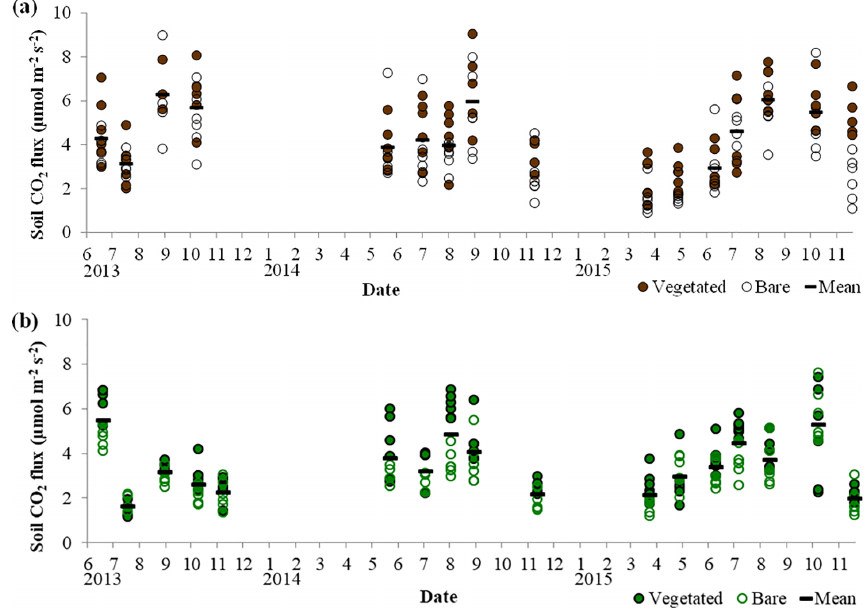
Figure 4. Variations in soil CO 2 efflux for each measurement event for combined grass and bracken plots, results separated for vegetated ( • filled circles) and bare ( ◦ open circles) soil plots at (a) the forest and (b) the grassland study sites ( n = 6).